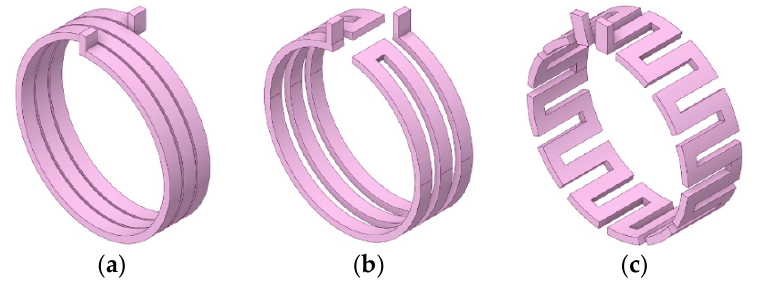
Figure 24. Different cooling water jacket structures ( a ) spiral, ( b ) dial, and ( c ) axial. To ensure that different water jackets have the same axial length and 6 L/min fluid flow, a simplified motor temperature field solution model including water jackets, end caps, stator core, and equivalent winding is used. The heat source density of the stator core and the winding heat source density are set as the base speed condition corresponding to the heat sources 329,196 W/m 3 and 544,613 W/m 3. At the initial temperature of the water flow of 65 ◦ C, the flow rate, pressure loss, and temperature comparison of each component of the three structures are shown in Figure 25.